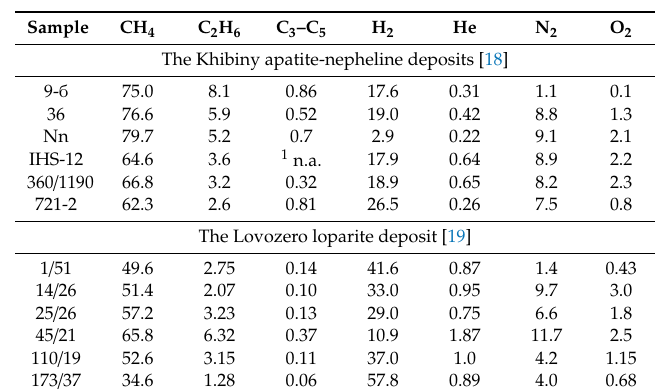
Table 3. Chromatographic compositional analysis (vol. %) of natural free gases minimally contaminated by the atmospheric air in shot-holes and boreholes: